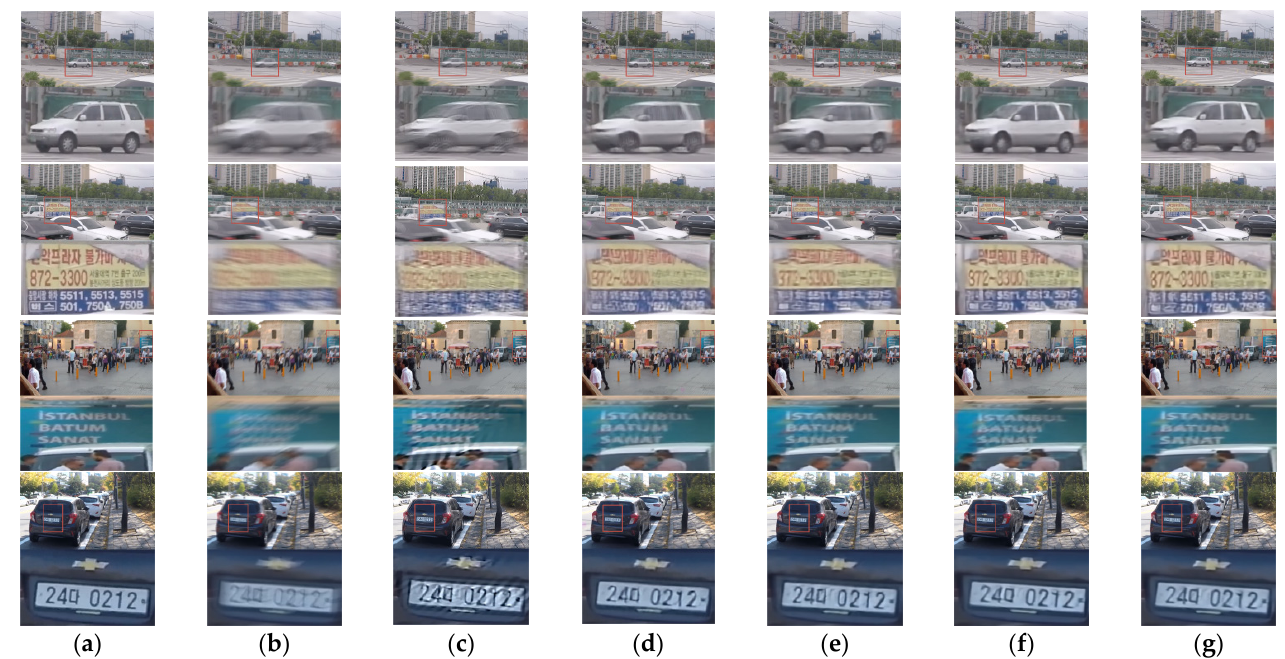
Figure 5. Experimental results on the GOPRO test dataset. ( a ) ground truths; ( b ) blurred images; ( c ) deblurring results of [24]; ( d ) deblurring results of [33]; ( e ) deblurring results of [29]; ( f ) deblurring results of [26]; ( g ) deblurring results of IDC (proposed).